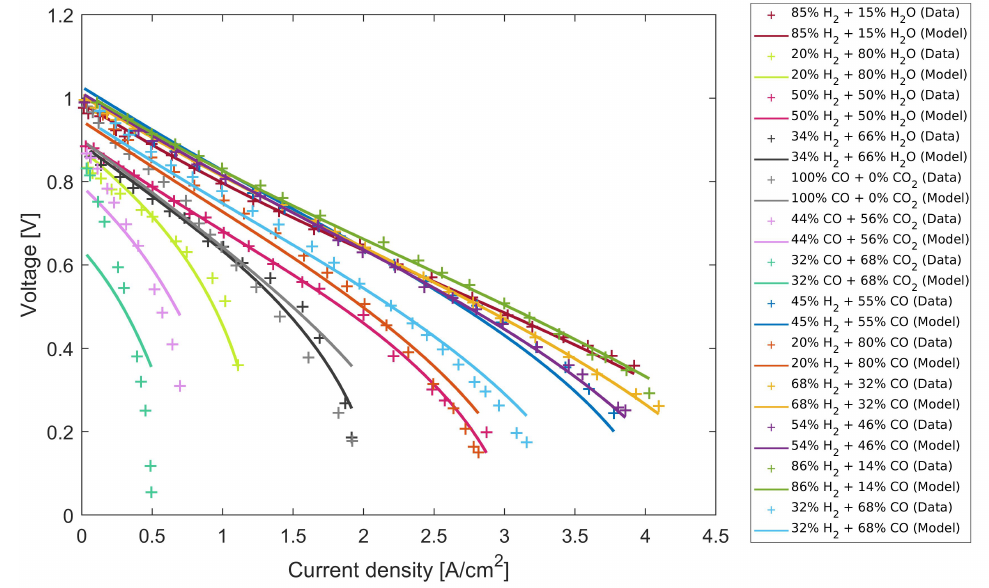
Figure 4. The results of the model calibrated with known values of calibration parameters from the literature as given in Appendix B for multiple polarisation